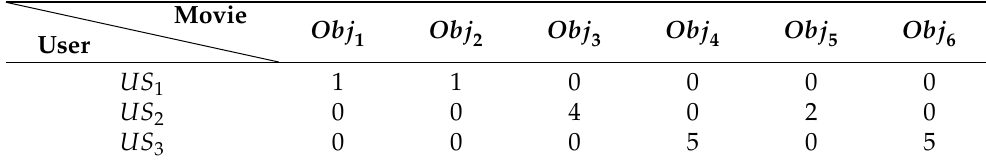
Table 1. User-Movie rating dataset.